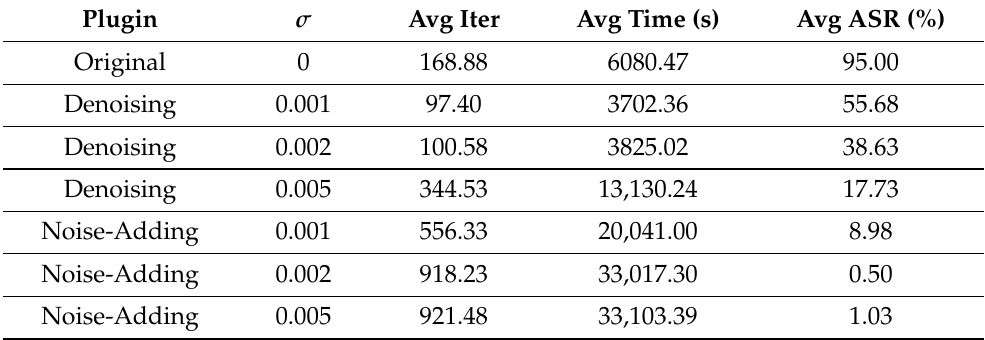
Table 4. Performance evaluation of proposed defense system against FakeBob attacks in I-Vector SV